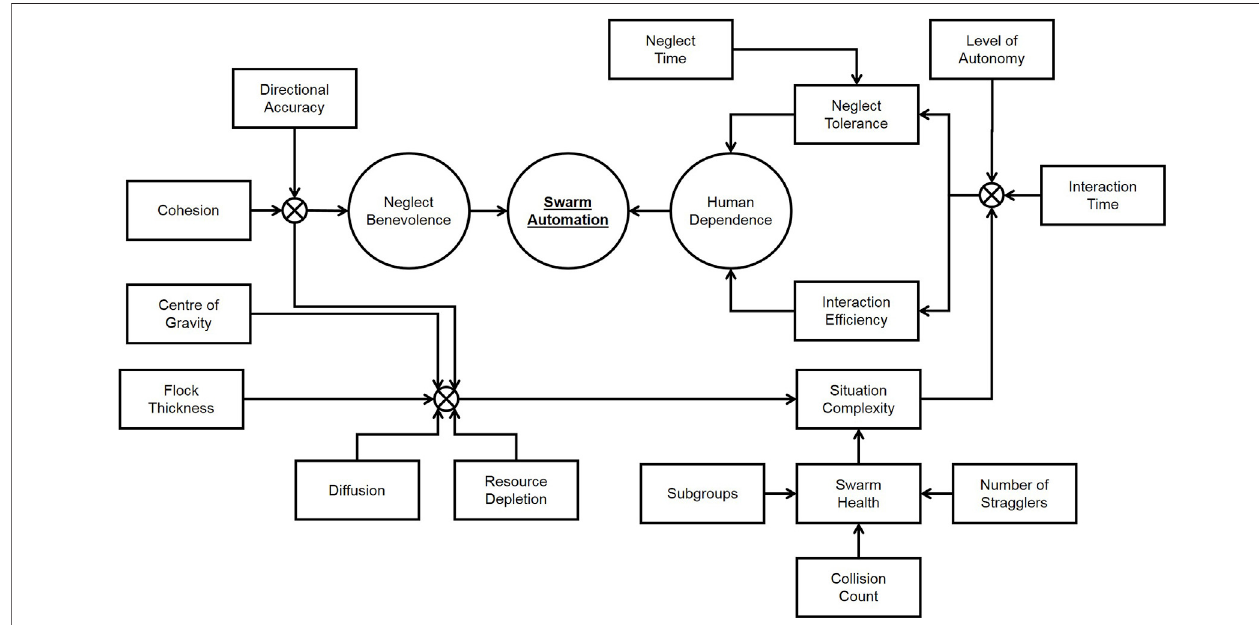
FIGURE 3 | Metrics for swarm